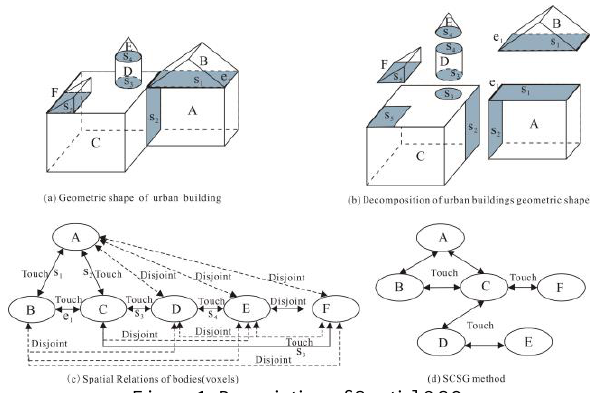
Figure 1. Description of Spatial